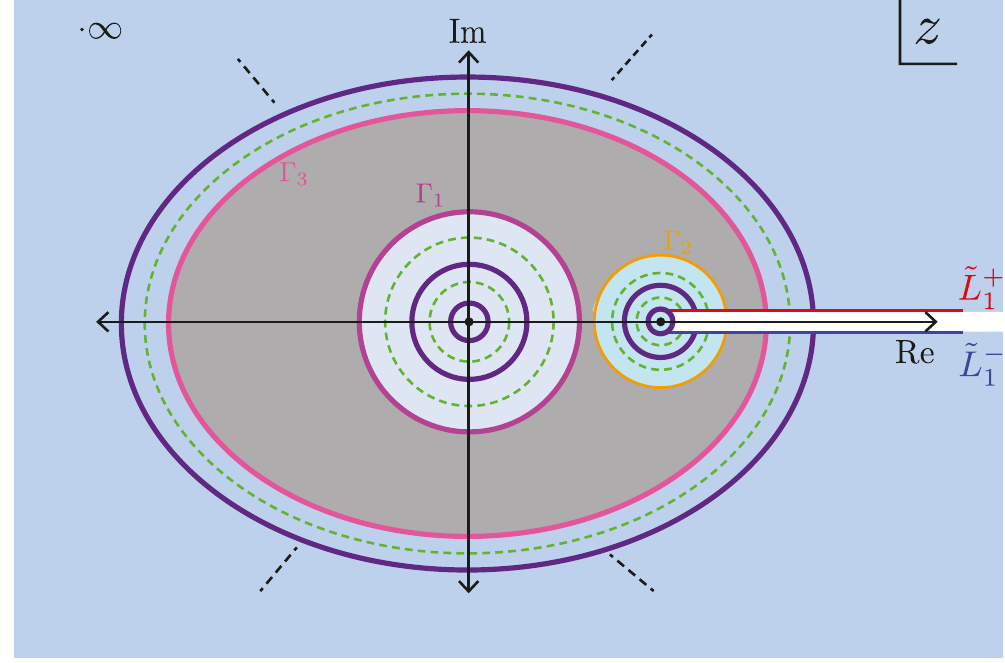
Figure 3 . The corresponding geometry on the z -plane after we pullback the metric (3.24) from the ρ 1 -plane above. Note that the gray region would be endowed with the hyperbolic metric with geodesic boundaries Γ i